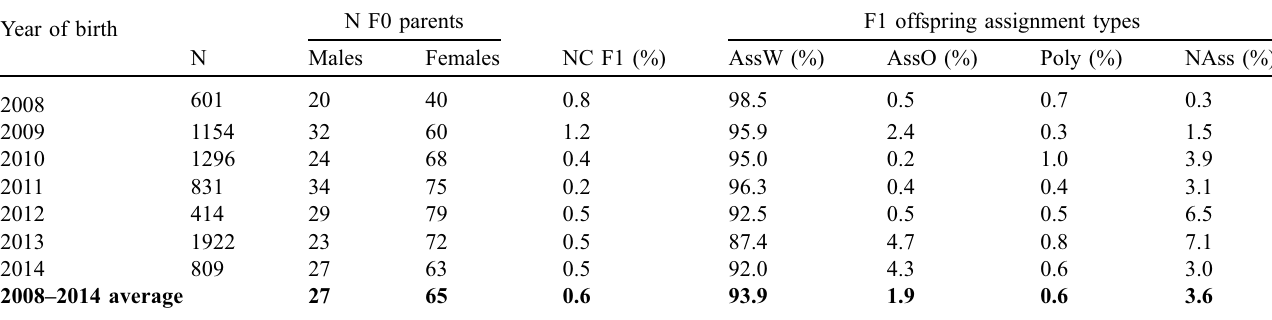
Table 6. Assignment of F1 salmon broodstock to their F0 parents. Year of birth N F0 parents F1 offspring assignment